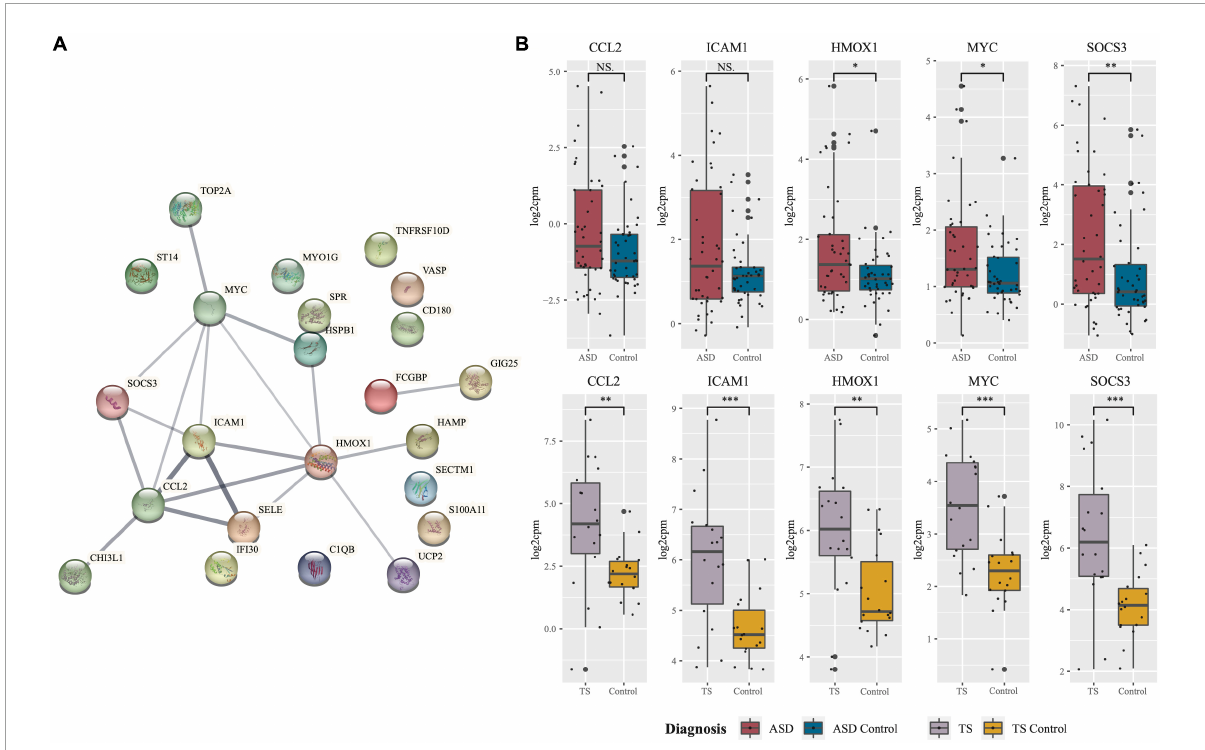
FIGURE3 Protein network of common differentially expressed genes and expression of hub genes in autism spectrum disorders (ASD and Tourette syndrome (TS). (A) Protein-protein-interaction (PPI) network of genes found to be commonly differentially expressed in ASD and TS. The network consists of nodes (circles) and edges (lines) representative of predicted functional associations of the common protein-coding genes. Edge thickness is indicative of the strength of predicted evidence. (B) Hub genes central to the network were identified using Cytoscape, and the expression (log2cpm; y-axis) of the five hub genes in cases and neurotypical control (NC) cohorts. Expression of the five hub genes in ASD cases ( n = 42; red) against neurotypical controls ( n = 43; blue) and TS cases ( n = 9; purple) and neurotypical controls ( n = 9; yellow). The median is shown as the black line in each group’s box, with the small black dots representing each sample. The whiskers on either side of the boxes represent the minimum (Q1-1.5 ∗ IQR) and maximum (Q3 + 1.5 ∗ IQR) log2cpm excluding outliers. The big black dots represent potential outliers ( ∗∗∗ p < 0.001, ∗∗ p < 0.01, ∗ p < 0.05, NS, non-significant, Mann–Whitney–Wilcoxon Test). Network generated using